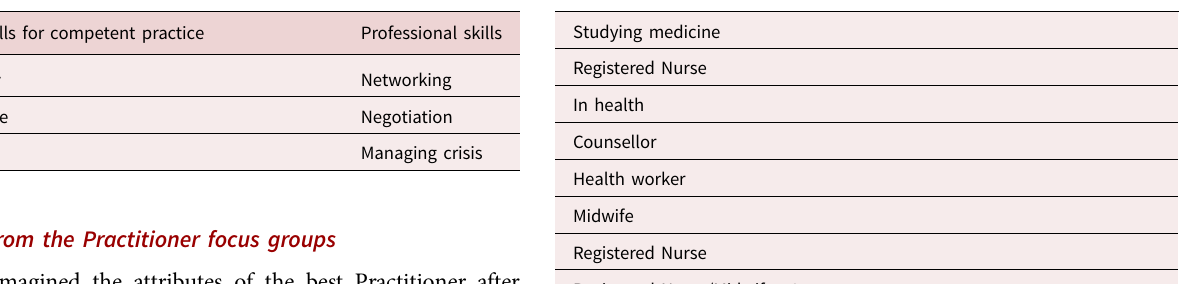
Table 2. Career aspirations of